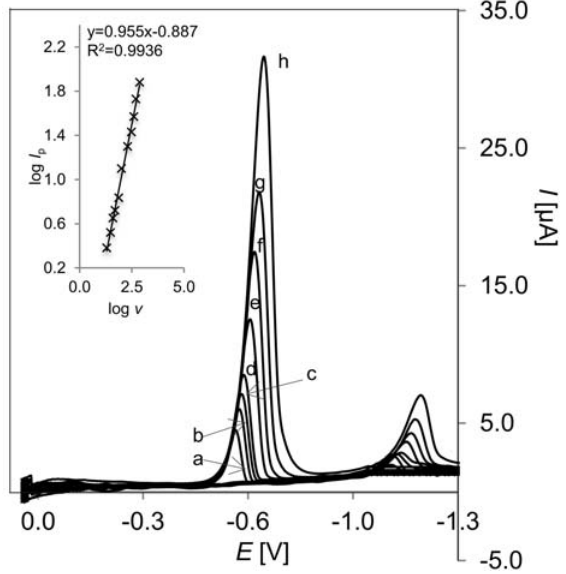
Figure 2. Cyclic voltammograms for 1 × 10 –5 mol L –1 aclonifen so- lution in borax buffer (pH 9.2) at various scan rates: (a) 30, (b) 50, (c) 75, (d) 100, (e) 200, (f) 300, (g) 500, and (h) 700 mV s –1 ; inset: the linear relationship between the log peak current I and log scan p rate v for the first peak ( E = –0.65 p